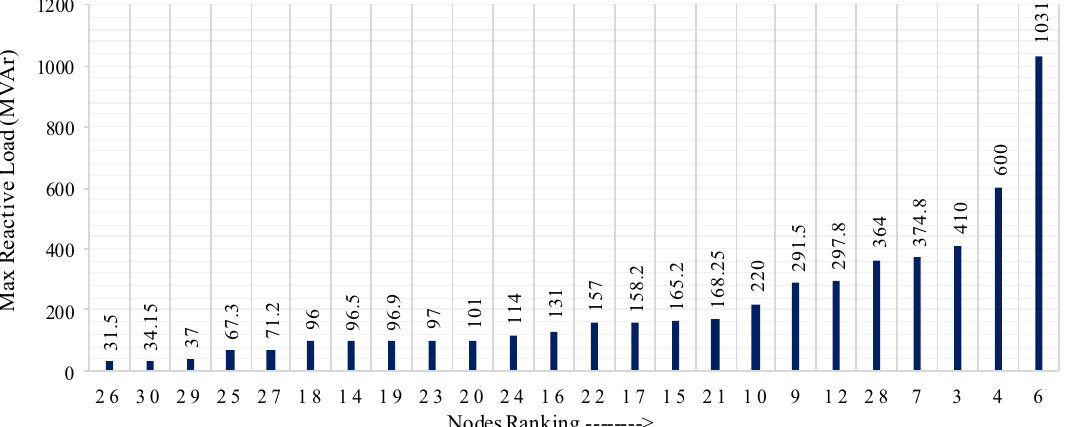
Fig. 7 Maximum permitted reactive power loading (MVAr) of the load buses in the IEEE